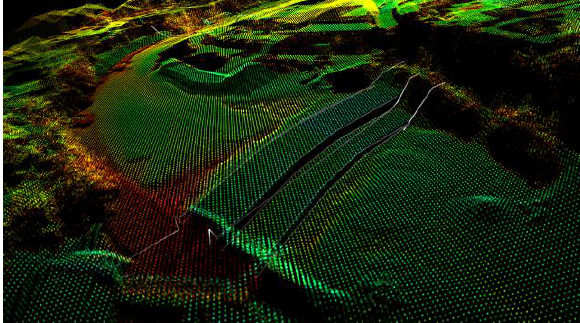
Figure 6: Scan-data point cloud and ground truth profiles of the weir sill located next to hydro power plant, upper stream reservoir and sediment structures. Colour corresponds to the local roughness of the